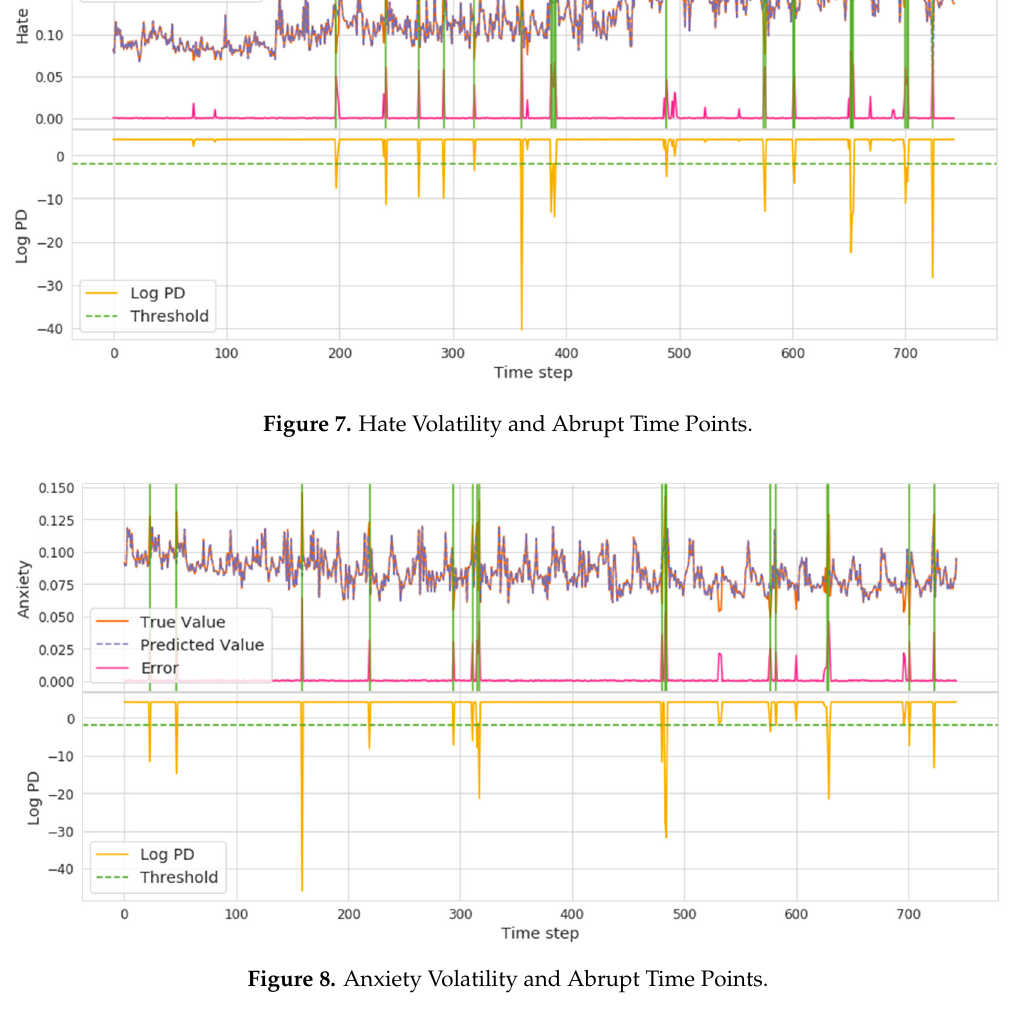
Figure 7. Hate Volatility and Abrupt Time Points.